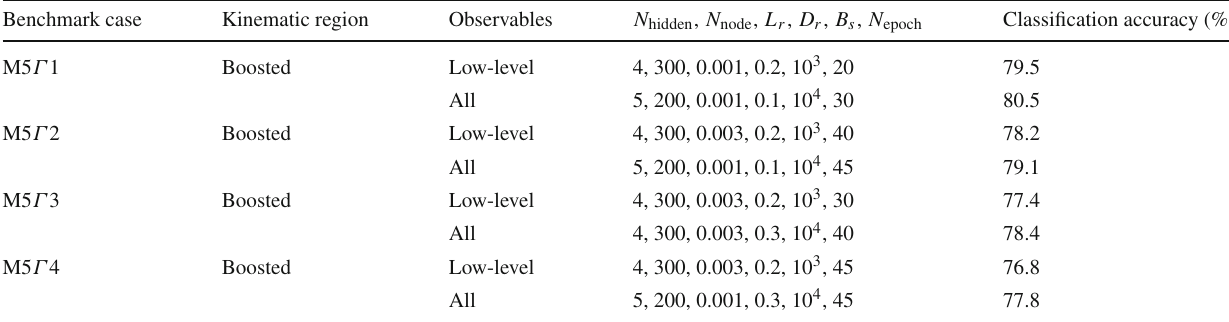
Table 4 The selected networks for M ρ = 5 TeV. N epoch is the epoch number when we cut the training Benchmark case